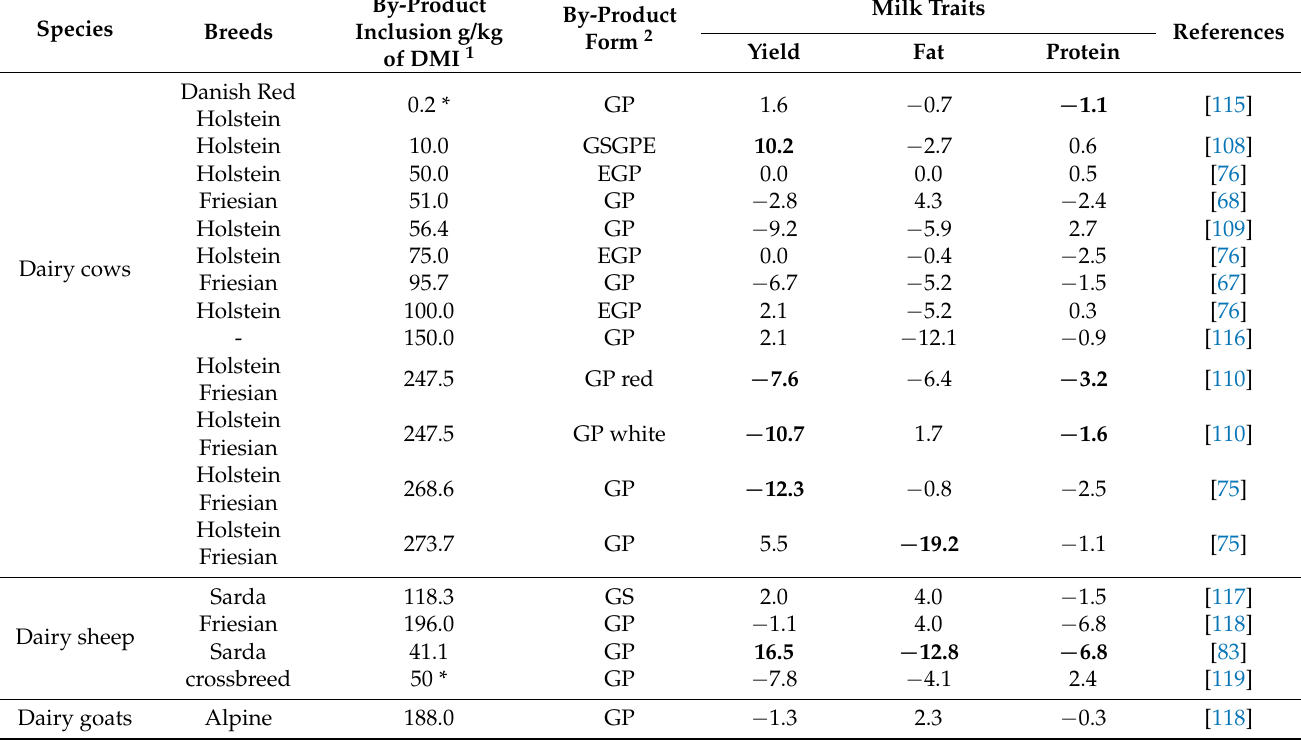
Table 2. Effect of grape by-products included in dairy ruminants’ diets on milk yield, fat%, and protein%. Data are reported as the proportional difference between the treatment group, at the respective level of inclusion, and the control group.